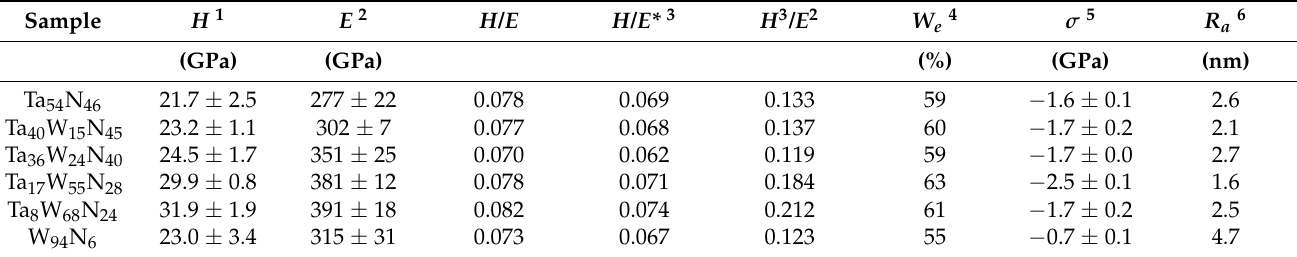
Table 3. Mechanical properties of the TaWN/Ta/Si